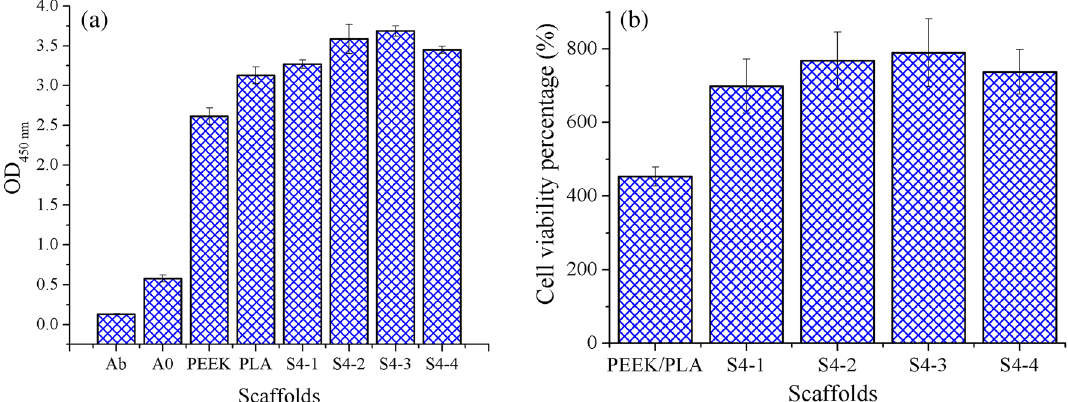
Figure 15. ( a ) Absorbance and ( b ) cell viability percentage of scaffolds evaluated by CCK-8 (Ab denotes the test well without cell and scaffold, and A0 denotes the test well without scaffold).